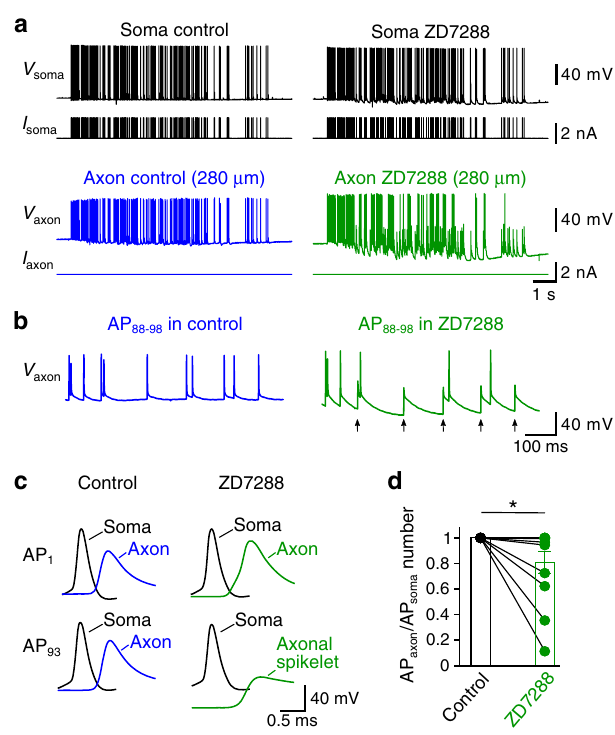
Fig. 4 HCN channels ensure reliable propagation of a physiologically relevant AP pattern in PV + -BC axons. a Simultaneous soma – axon recording of APs elicited by stimulating the soma with a physiologically relevant spike pattern in control (left) and 20 µ M ZD7288 (right). The distance between axonal and somatic sites was 280 µ m. b Axonal membrane potentials in a between the 88th and 98th somatic APs (AP 88 – 98 ) plotted on an expanded time scale. Black arrows indicate axonal propagation failures in ZD7288. c First (top, AP 1 ) and 93rd (bottom, AP 93 ) APs of the AP trains in a plotted on an expanded time scale. Note that the 93rd somatic AP in ZD7288 is associated with a spikelet at the axonal recording site, indicating an AP propagation failure. Black traces in a – c , somatic voltage and current; blue traces, axonal voltage and current in control; green traces, axonal voltage and current in ZD7288. d Summary graph showing that 20 µ M ZD7288 reduced the propagation reliability of the physiologically relevant AP pattern. AP propagation reliability was quanti fi ed by dividing the number of full-blown APs in the axon by that in the soma during the spike train. A value of less than one indicates AP propagation failures. AP propagation failures were detected in 7 out of 12 distal (>100 µ m) soma – axon recordings after applying ZD7288. Data points from the same experiment are connected by lines. * indicates P = 0.02 ( n = 12 soma – axon recordings, two-sided Wilcoxon signed rank test). Error bars represent ± SEM. Source data are provided as a Source data fi